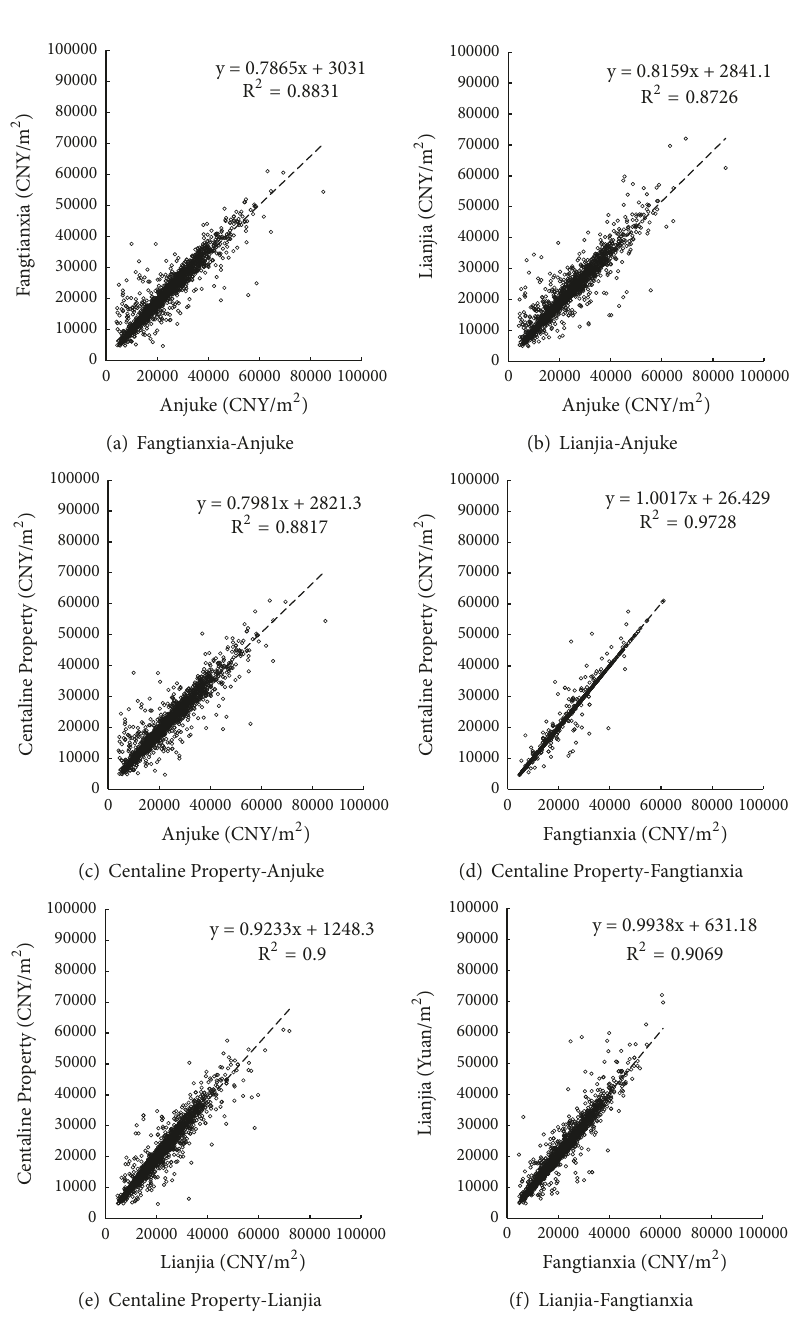
Figure 5: Scatter plots of neighbourhoods’ second-hand housing prices (June 7,